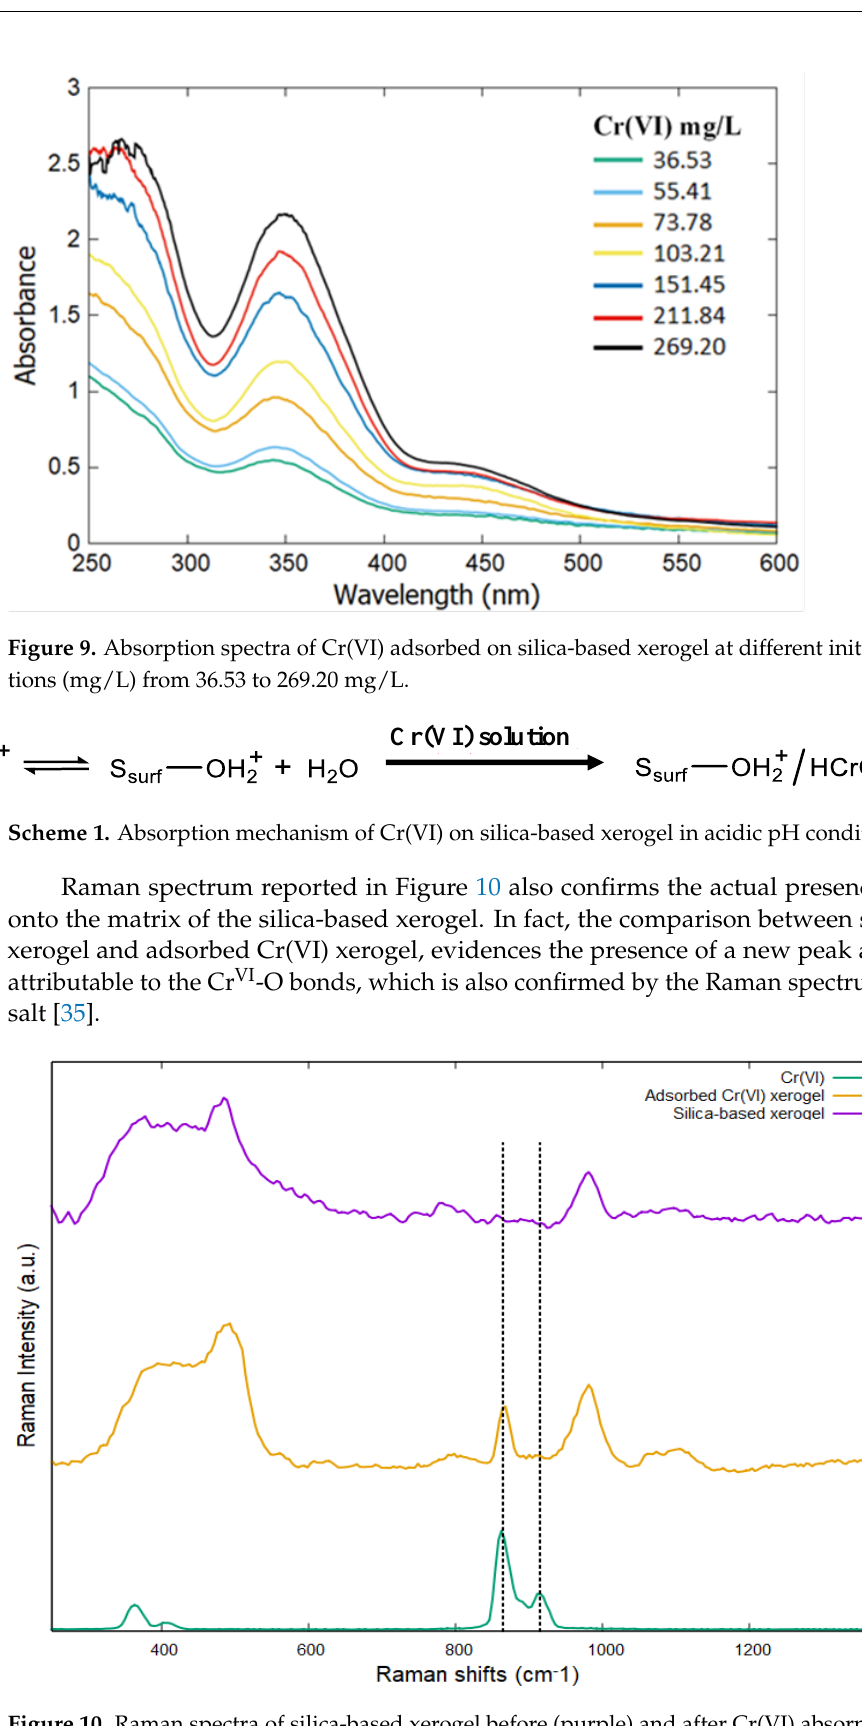
Figure 10. Raman spectra of silica-based xerogel before (purple) and after Cr(VI) absorption (yellow) and K 2 CrO 4 powder (green).